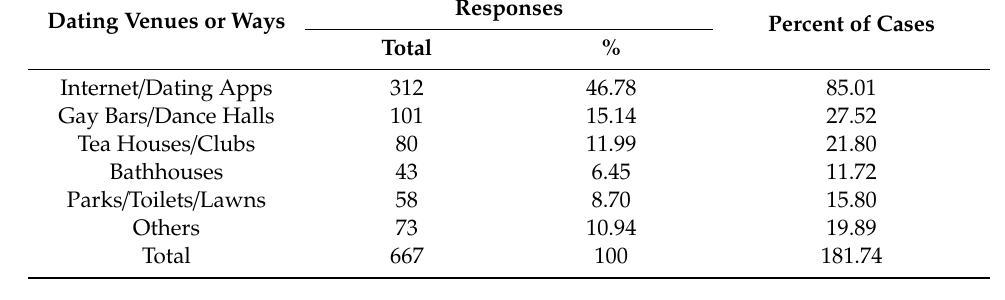
Table 5. Multiple responses of dating venues or ways to Chinese gay men.